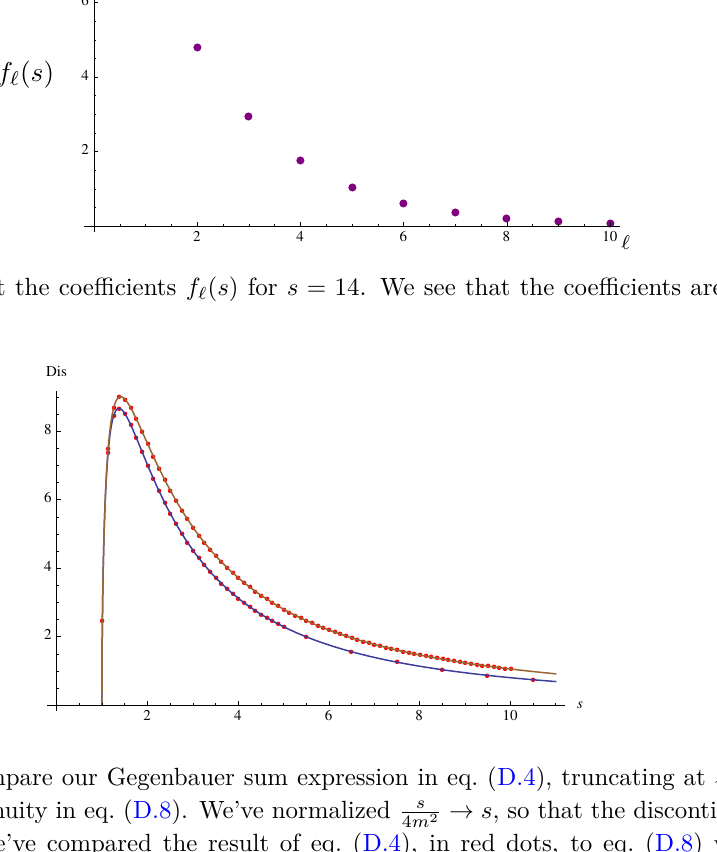
→ s , so that the discontinuity begins 4 m 2 , and the blue curve for cos θ = 1 / 6 . Both exhibit 2